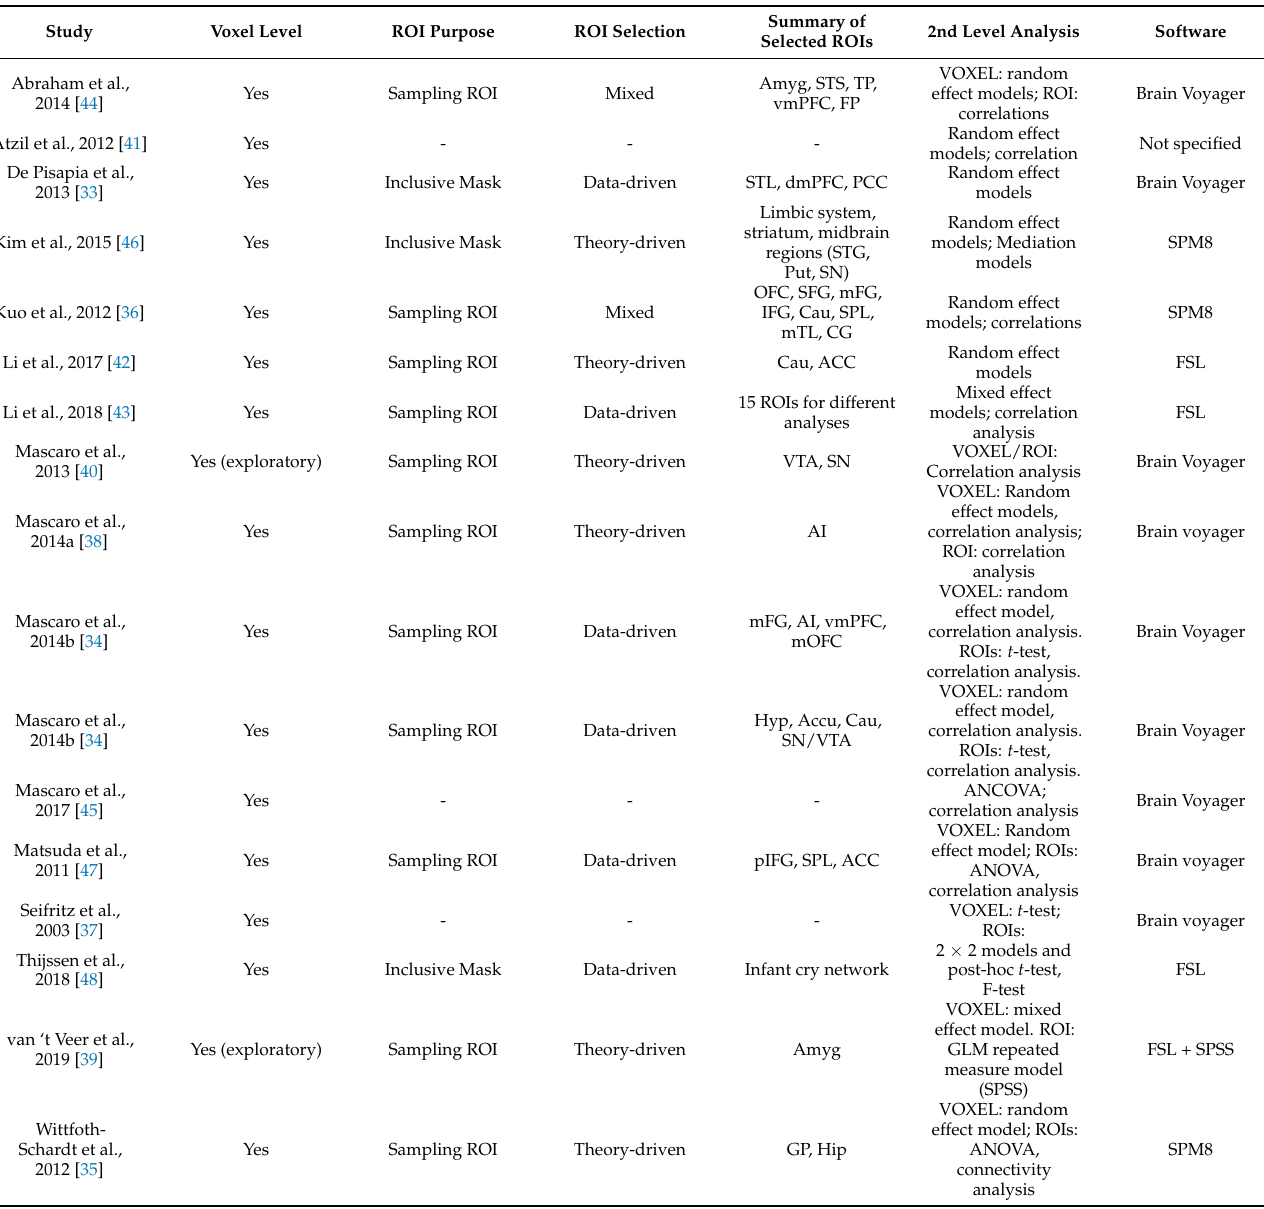
Table 4. Summary of the fMRI analytical